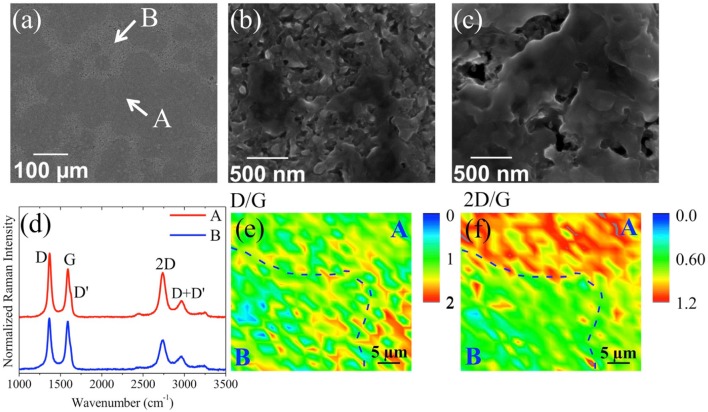
SEM images of a-C (5 nm)/Ni/Si after thermal processing at (a) 500 × and 12,000 × magnifications for the areas A (b) and B (c) showing a 3D porous structure; (d) typical Raman spectra at 442 nm taken in regions A and B. Raman mapping at 442 nm of the intensity ratio on 40 μm × 40 μm of (e) D/G and (f) 2D/G, respectively. The dashed lines are guides delimiting regions A and B [Reproduced from Tite et al. (2016) with permission of Elsevier].